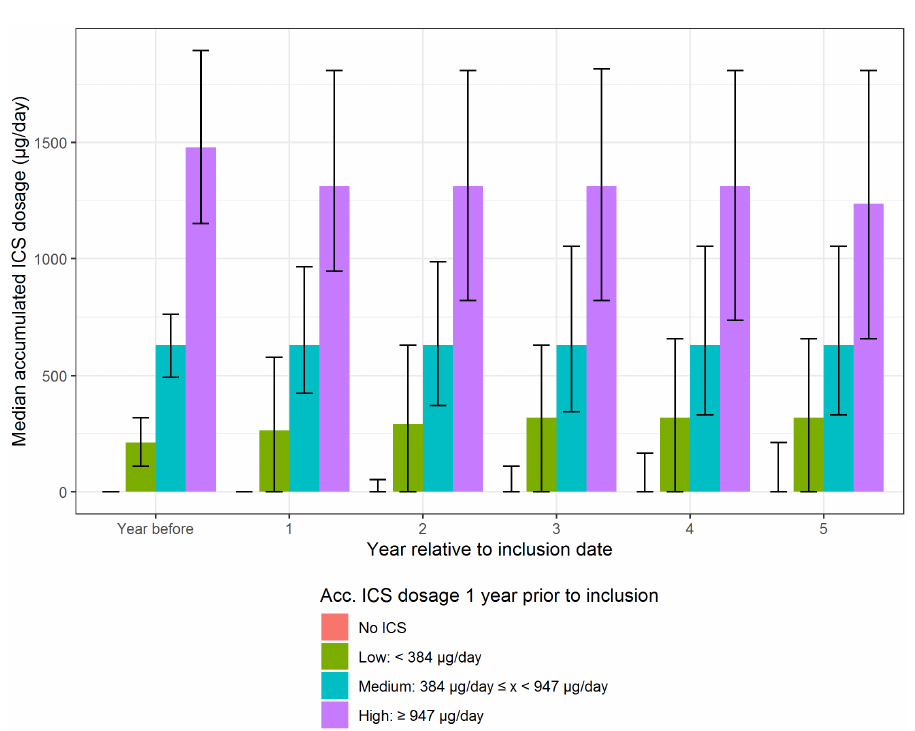
Figure A1. Median yearly accumulated ICS dose for the 4 groups of the study. Vertical bars represent the interquartile range. ICS: Inhaled corticosteroid.